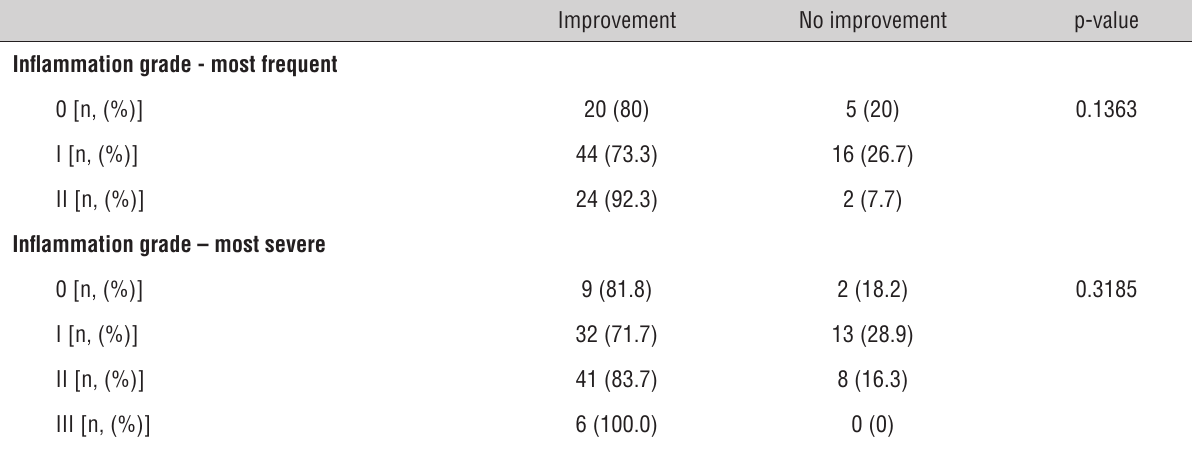
Table 4 - The association between inflammation grade and symptomatic improvement.